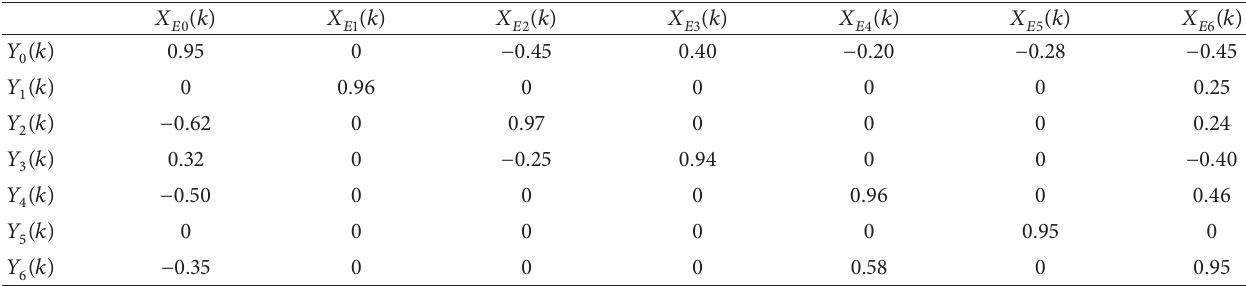
of the sensitivity of emotional OF